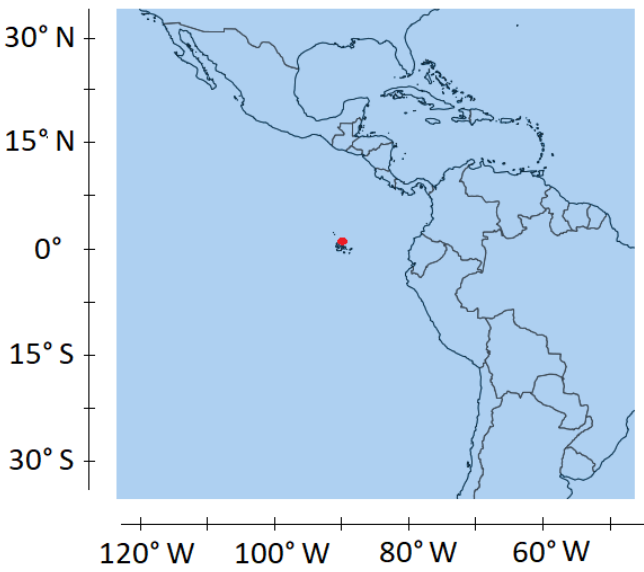
Figure 2. Location of the borehole V21–30 (in red) in the eastern equatorial Pacific near the Galapagos Islands.